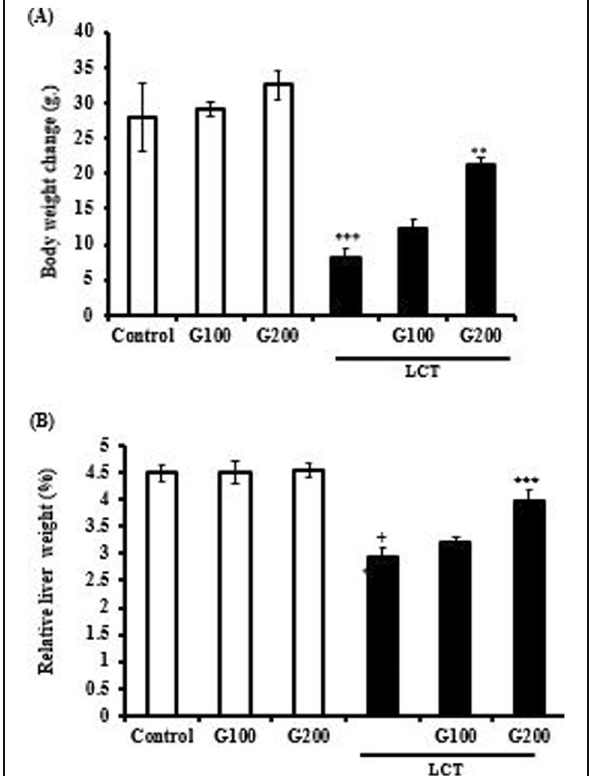
Fig. 1 Effect of Panax ginseng on lambda cyhalotherin-induced changes in a body weight (g) and b relative liver weight (%). The results were expressed as mean ± SE ( N = 6). Where G100, 100 mg Panax ginseng ; G200, 200 mg Panax ginseng ; LCT, lambda cyhalotherin administered rats. Values were considered significantly different at + P < 0.05, +++ P < 0.001 versus control group and ** P < 0.01, *** P < 0.001 versus LCT